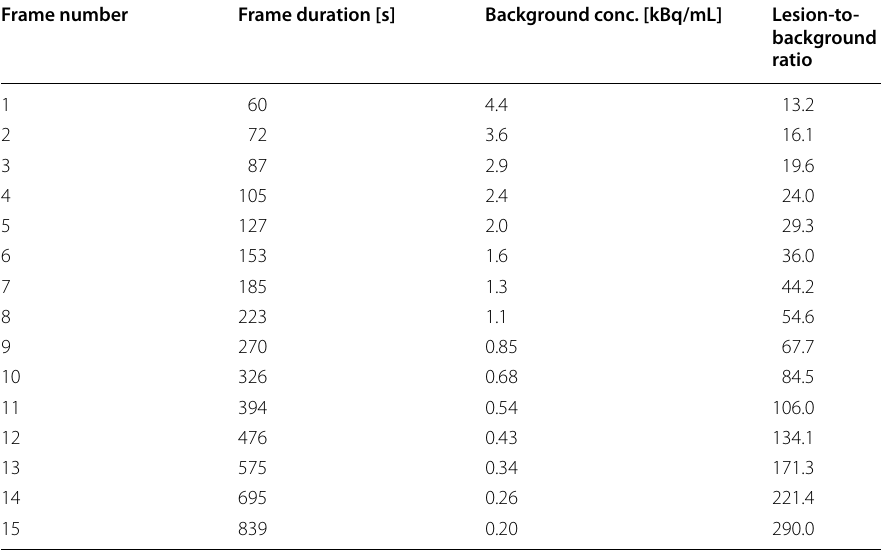
Table 2 Scan protocol using Probe-IQ pelvis (first scan) Frame